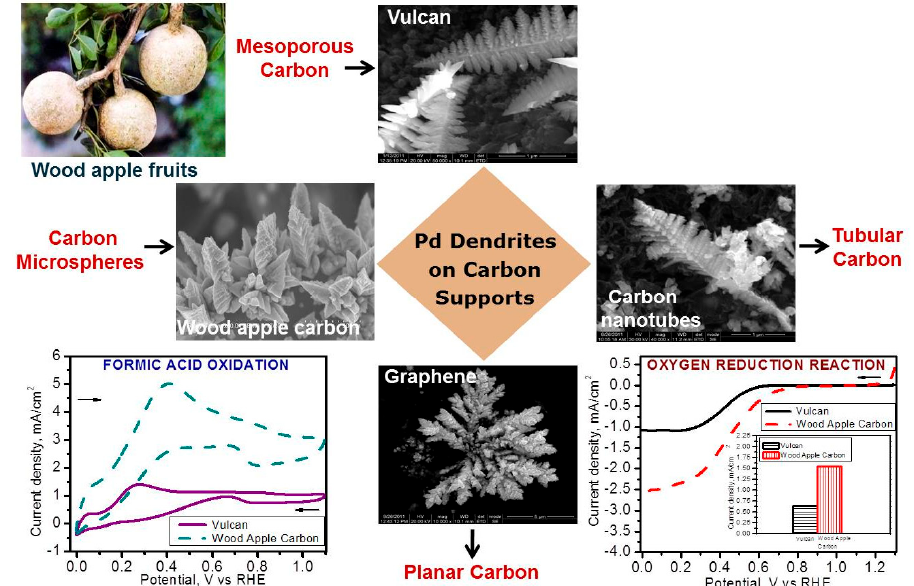
Figure 7. Scanning electron micrographs showing the morphological transitions of palladium sup- ported on Vulcan. Reproduced with permission from [103].